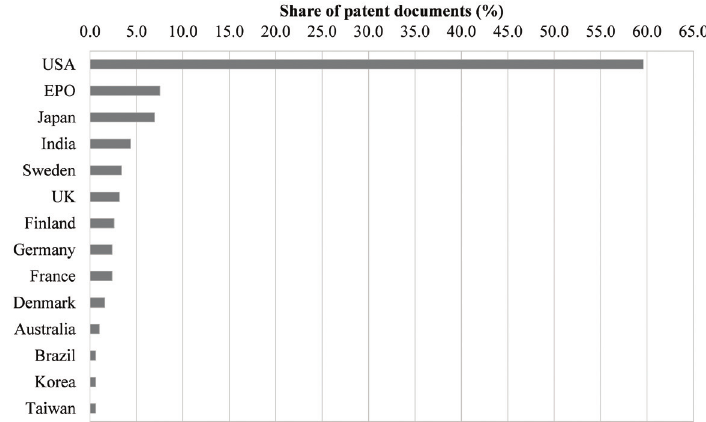
Figure 2. The main priority countries of patent documents filed at the USPTO. Source: DII.